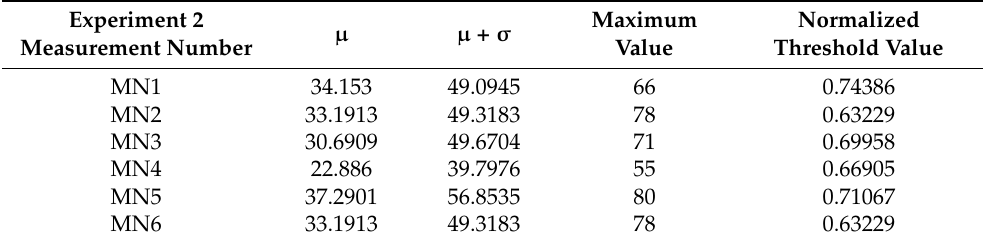
Table 3. Distribution Parameters and Threshold Values of